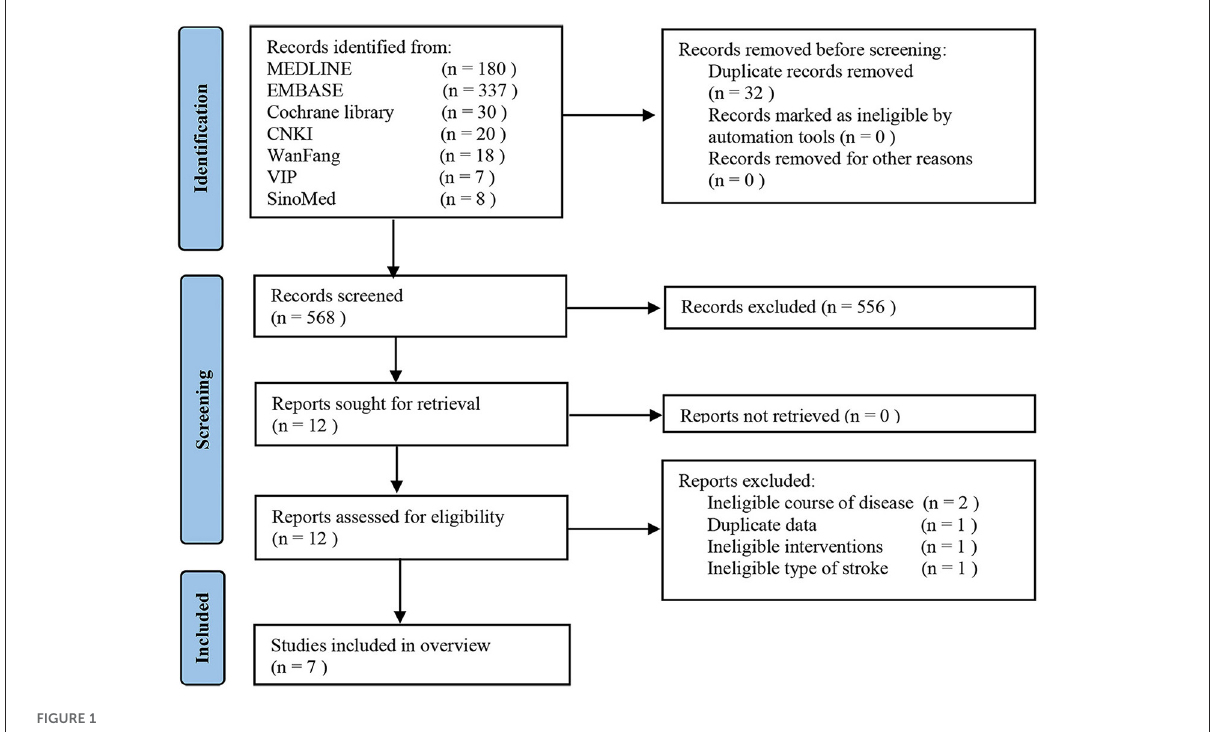
FIGURE1 Flow diagram for identification of